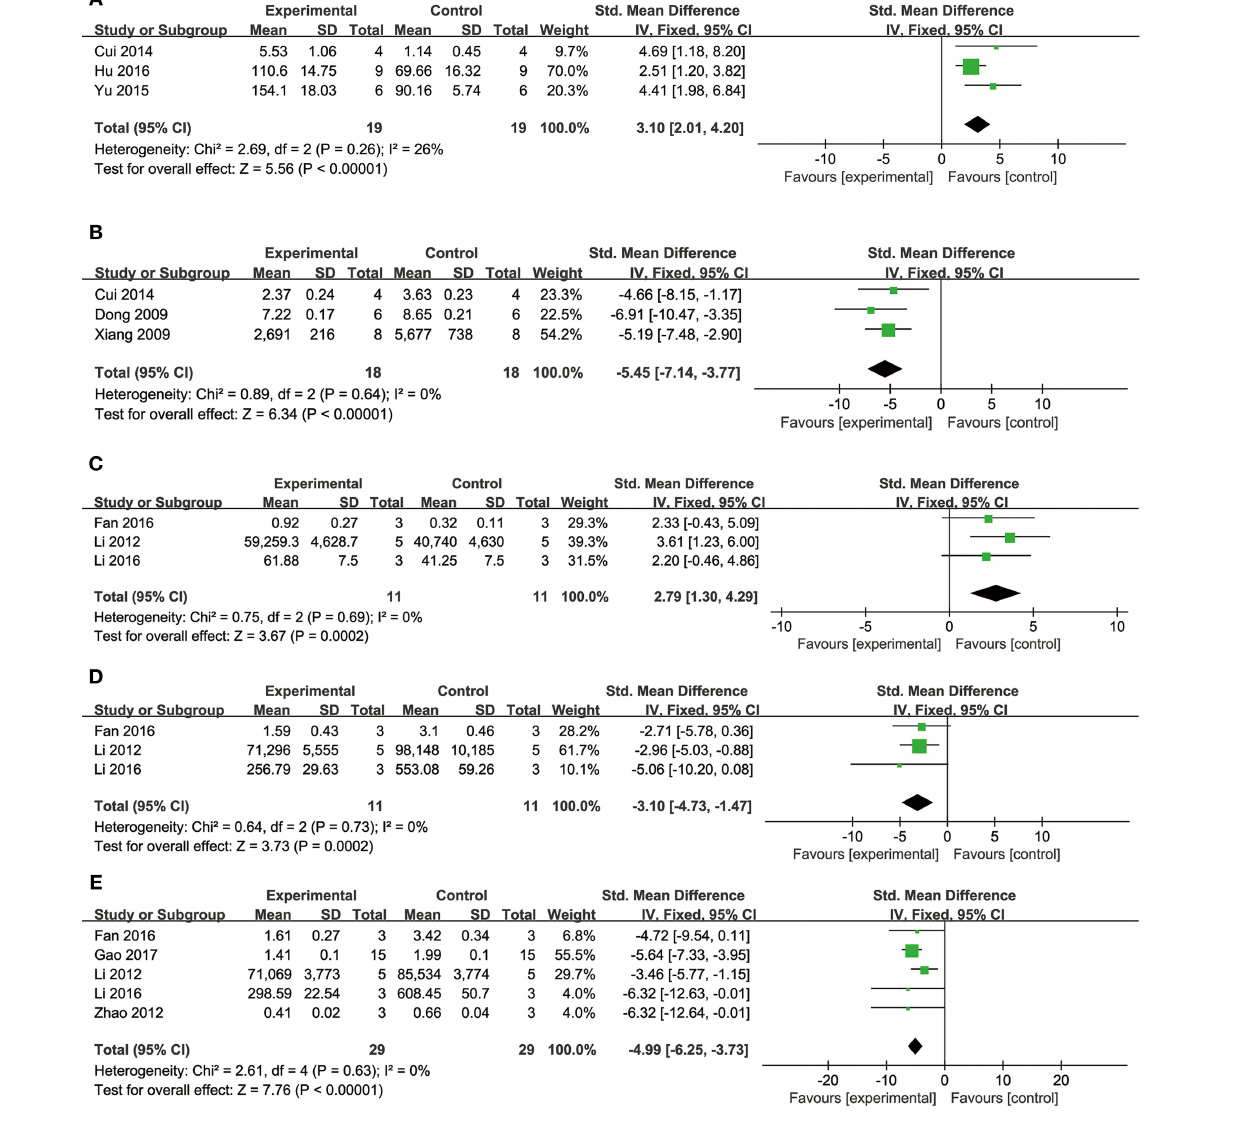
FIGURE 4 | The forest plot: (A) in vivo effects of danshensu for increasing SOD compared with controls ( n = 19 per group); (B) in vivo effects of danshensu for reducing MDA compared with controls ( n = 18 per group); (C) in vivo effects of danshensu for increasing Bcl-2 compared with controls ( n = 11 per group); (D) in vivo effects of danshensu for reducing Bax compared with controls ( n = 11 per group); (E) in vivo effects of danshensu for reducing caspase-3 compared with controls ( n = 29 per group). SOD, superoxide dismutase; MDA, malondialdehyde; Bcl-2, B-cell lymphoma-2; Bax, BCL2-associated X protein. = 0.64, P = 0.73, I 2 = 0%; Figure 4D ); one study (Zhao et al., 95% CI: 2.10–4.20, P < 0.00001; heterogeneity χ 2 = 2.69, P = 0.26, I 2 = 26%; Figure 4A ); three studies(Dong et al., 2009; 2012) for reducing Bcl2/Bax ( P < 0.01); five studies (Li et al., Xiang et al., 2009; Cui et al., 2014) for reducing malondialdehyde 2012, 2016; Zhao et al., 2012; Fan et al., 2016; Gao et al., 2017) (MDA) ( n = 36, SMD: − 5.45, 95% CI: − 7.14 to − 3.77, P < for reducing caspase-3 ( n = 58, SMD: − 4.99, 95% CI: − 6.25 to − 3.73, P < 0.00001; heterogeneity χ 2 = 2.61, P = 0.63, I 2 = 0.00001; heterogeneity χ 2 = 0.89, P = 0.64, I 2 = 0%; Figure 4B ); three studies (Li et al., 2012, 2016; Fan et al., 2016) for increasing 0%; Figure 4E ); two studies (Quan et al., 2012; Li et al., 2016) B-cell lymphoma-2 (Bcl-2) ( n = 22, SMD: 2.79, 95% CI: 1.30– for reducing tumor necrosis factor- α (TNF- α ) ( n = 20, SMD: − 2.40, 95% CI: − 3.71 to − 1.10, P = 0.0003; heterogeneity χ 2 4.29, P = 0.0002; heterogeneity χ 2 = 0.75, P = 0.69, I 2 = 0%; = 0.11, P = 0.74, I 2 = 0%; Figure 5A ); one study (Quan et al., Figure 4C ); three studies (Li et al., 2012, 2016; Fan et al., 2016) for reducing BCL2-associated X protein (Bax) ( n = 22, SMD: 2012) for reducing Interleukin-1 (IL-1) and Interleukin-6 (IL-6) − 3.10, 95% CI: − 4.73 to − 1.47, P = 0.0002; heterogeneity χ 2 ( P < 0.05); two studies (Wei et al., 2016; Yin et al., 2017)